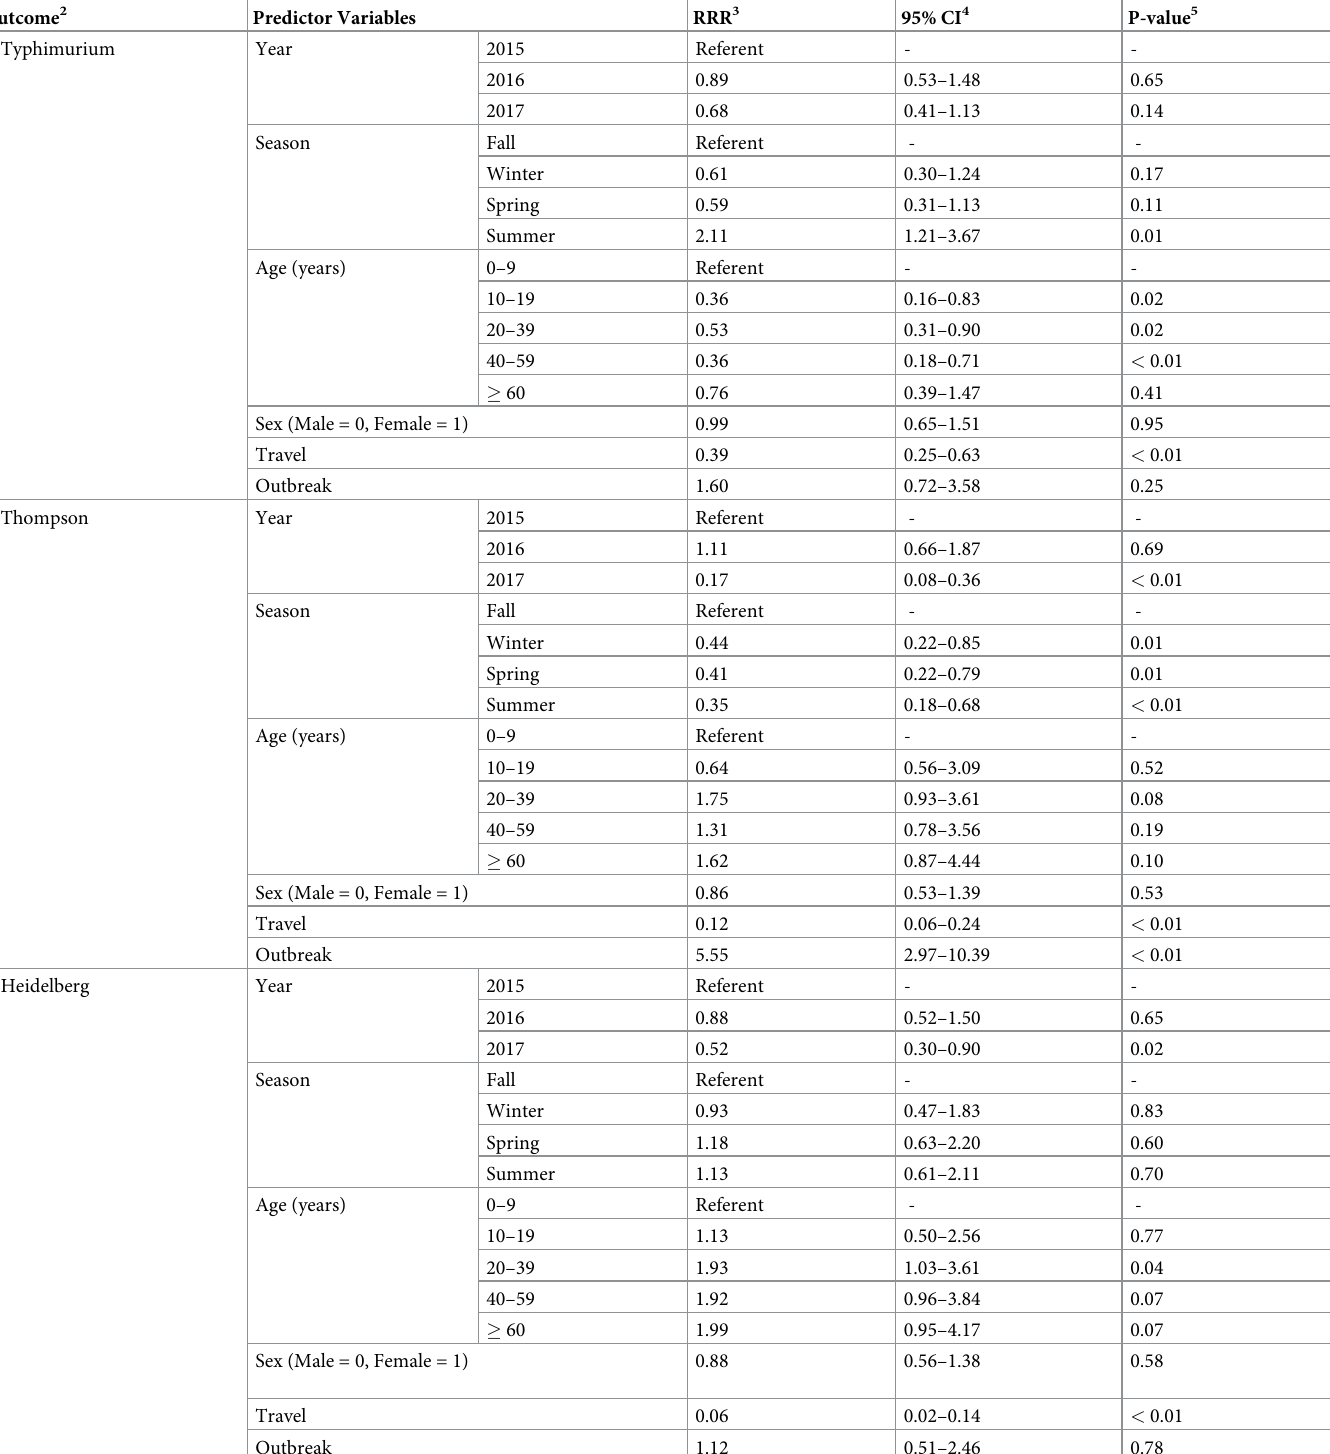
Table 3. Demographic and seasonal factors for nontyphoidal Salmonella enterica infections with major serotypes in the city of Toronto, Ontario, Canada, 2015– 2017 1 . Outcome